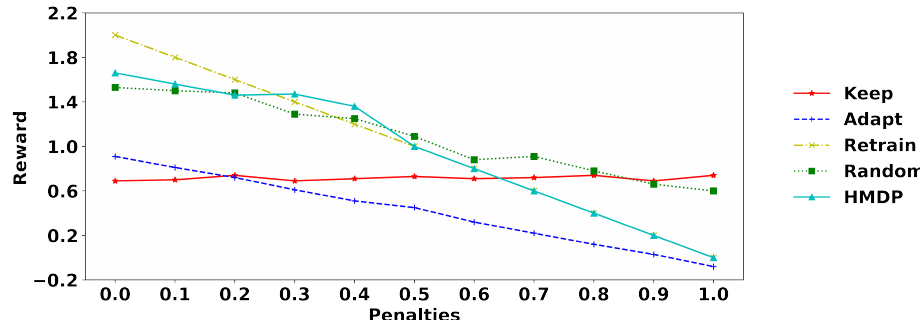
Figure 8. The average reward under different penalties.